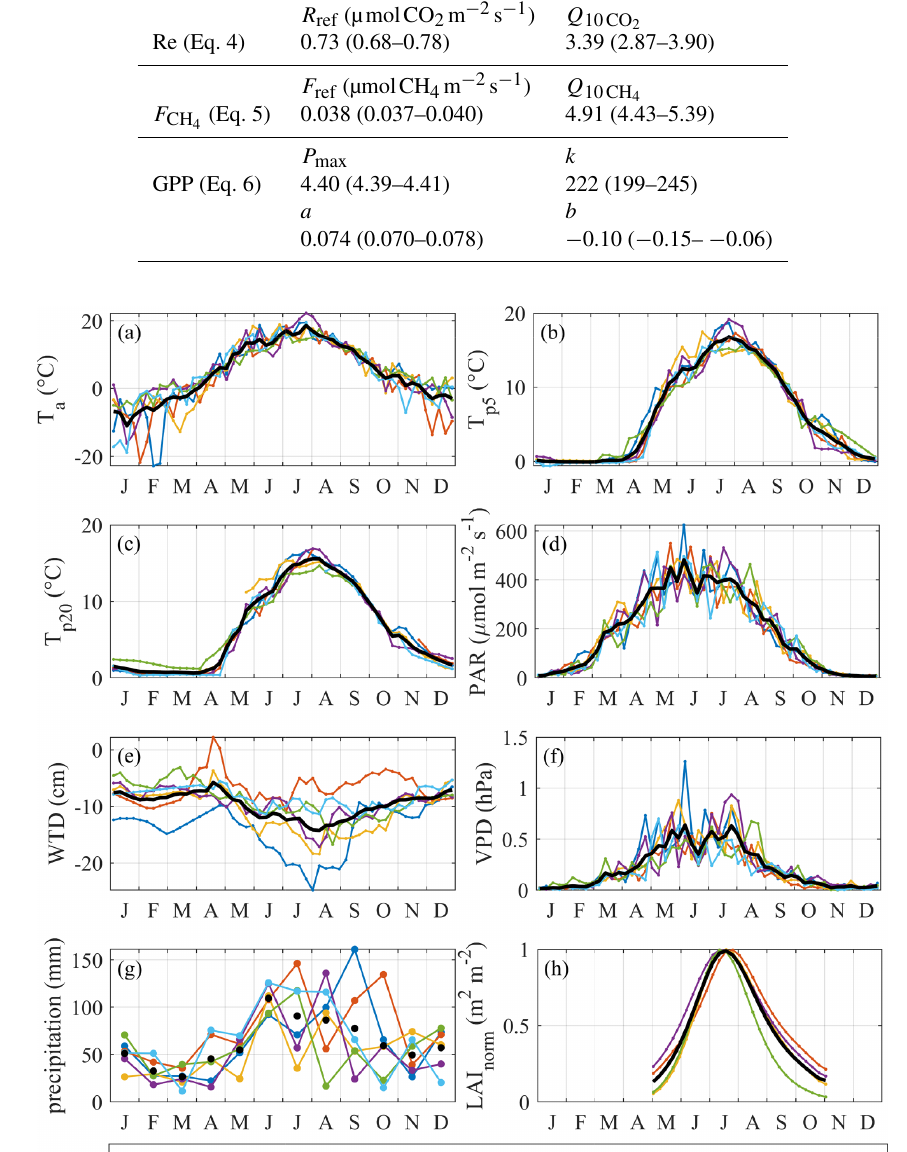
made using all quality-controlled data. The 95% confidence intervals are given in 4